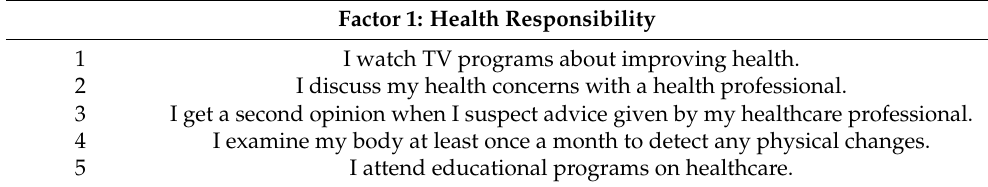
Table 3. Health-Promoting Lifestyle Profile Scale of Older